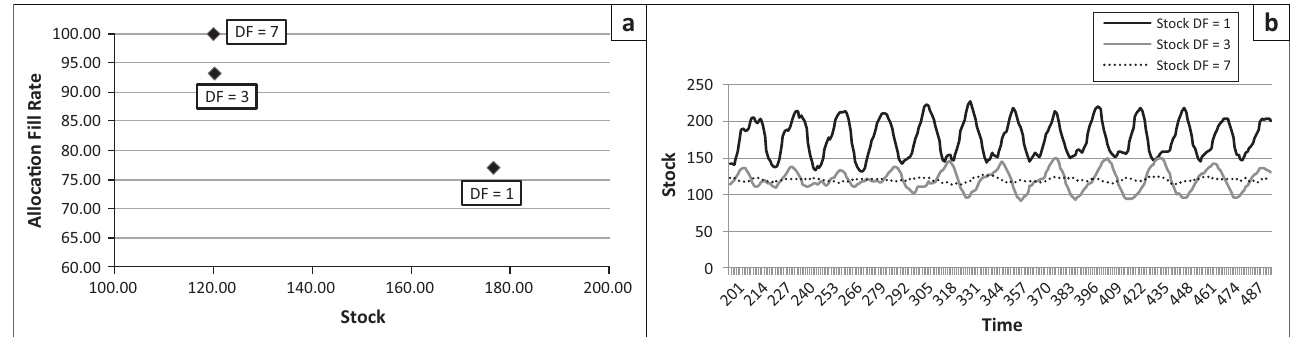
FIGURE 3: (a and b) Impact of the damping factor on a current model domestic supplier supply chain.